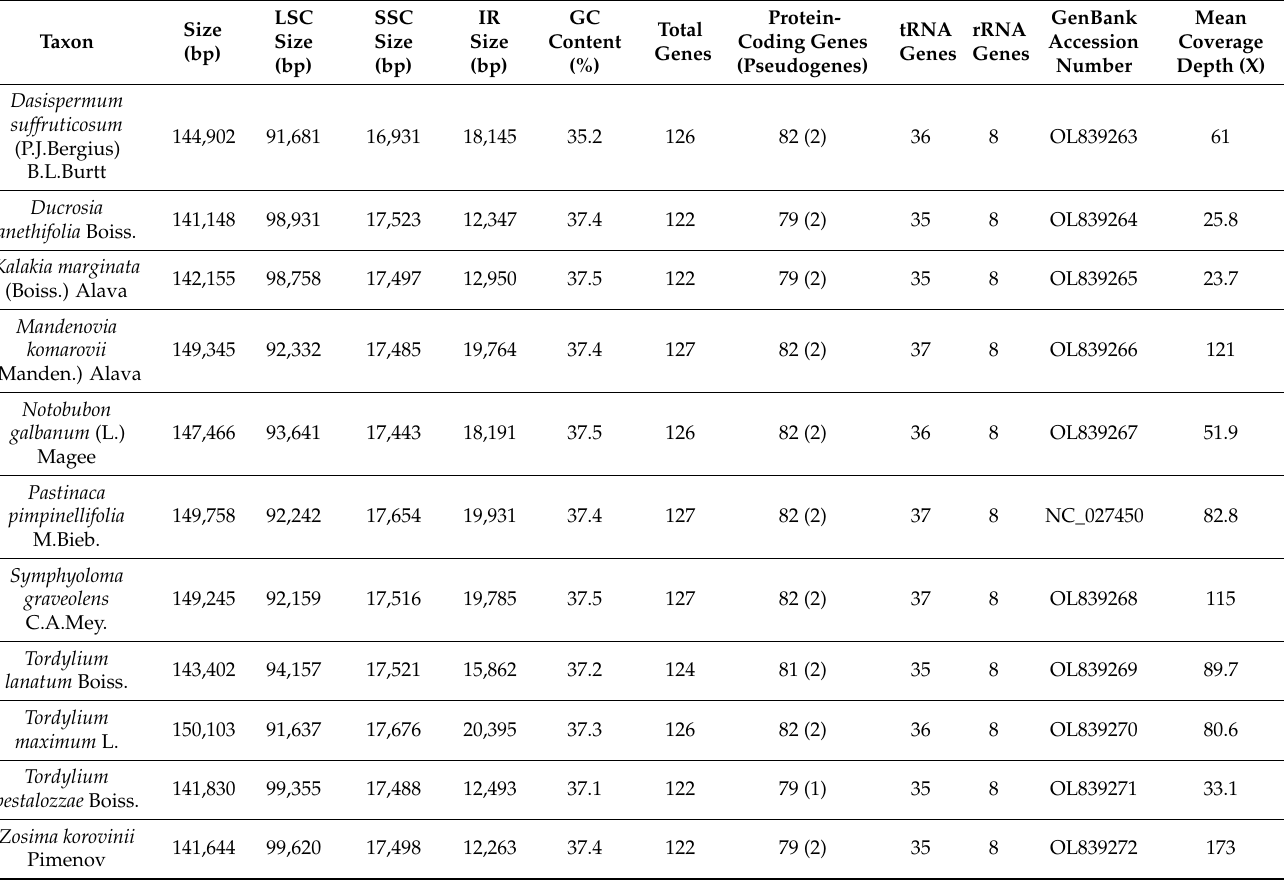
Table 1. Characteristics of plastid genomes (IR: inverted repeat, LSC: large single-copy region, SSC: small single-copy region) and accession numbers of eleven plastid genomes from Tordylieae tribe